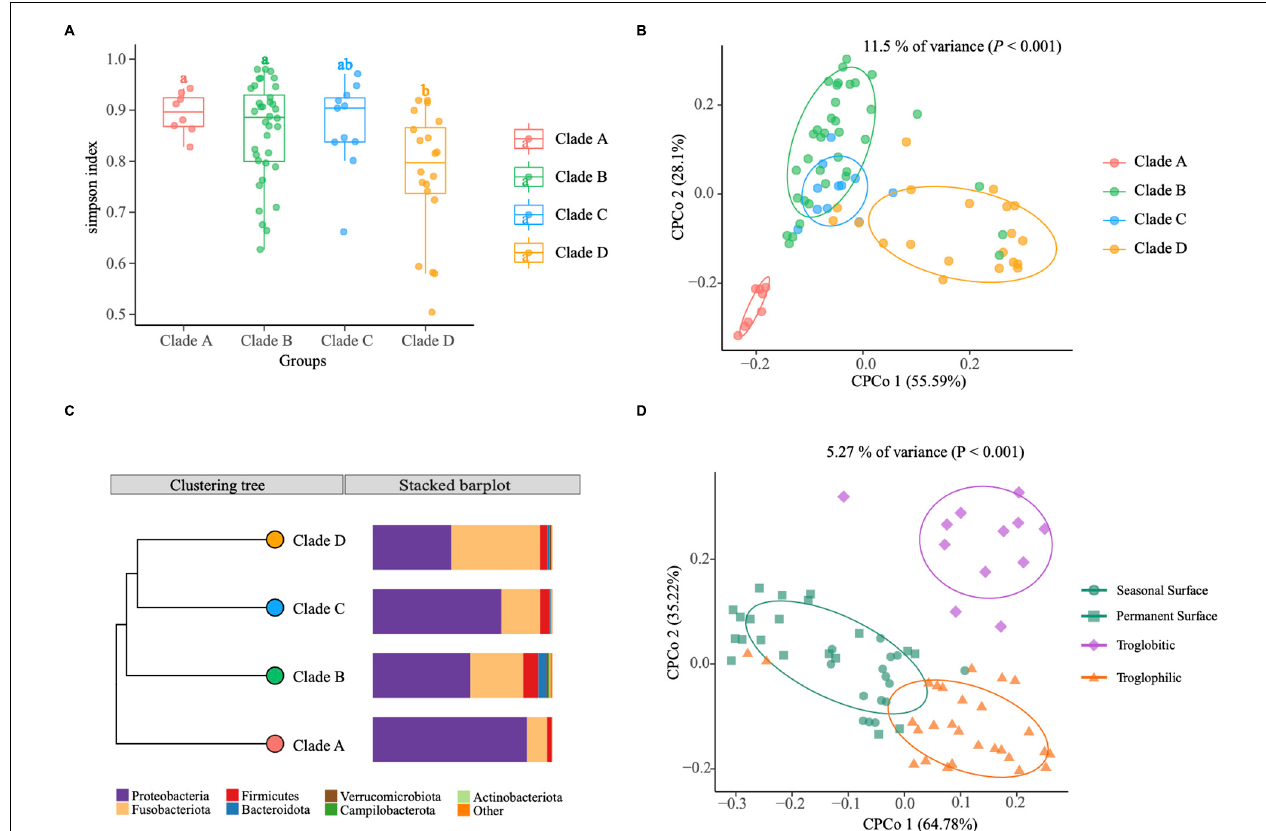
FIGURE 3 | The gut microbiomes of Sinocyclocheilus species ( N = 24) in context of phylogenetic clades and habitats. (A) Simpson index. The bottom and top of the box are the first and third quartiles, the band inside the box is the median, and the ends of the whiskers represent the minimum and maximum. Different letters indicate significant difference between groups (ANOVA, Tukey HSD test). (B) CPCoA of Bray–Curtis dissimilarity showing host phylogeny has significant effect on gut microbiome (11.5% of total variance was explained by the phylogenetic clade, P < 0.001). Total number of fishes used: clade A ( N = 8), clade B ( N = 36), clade C ( N = 11) and clade D ( N = 20). The ellipses include 68% of samples from each group. (C) The UPGMA tree with unweighted Unifrac distance matrices representing bacterial community composition of phylogenetic clades at phylum level indicated with bar plots. (D) CPCoA of Bray–Curtis dissimilarity showing living habitat has significant effect on gut microbiome (5.27% of total variance, explained by the phylogenetic clade, P < 0.001). Total number of fishes analyzed: Surface ( N = 35), Troglobitic ( N = 12), Troglophilic ( N = 28). The ellipses include 68% of samples from each